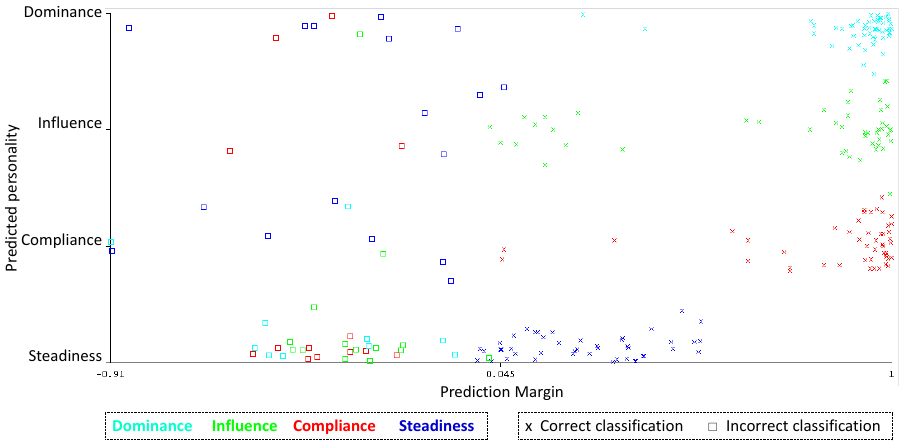
Figure 5. Prediction margin versus predicted personality comparation.